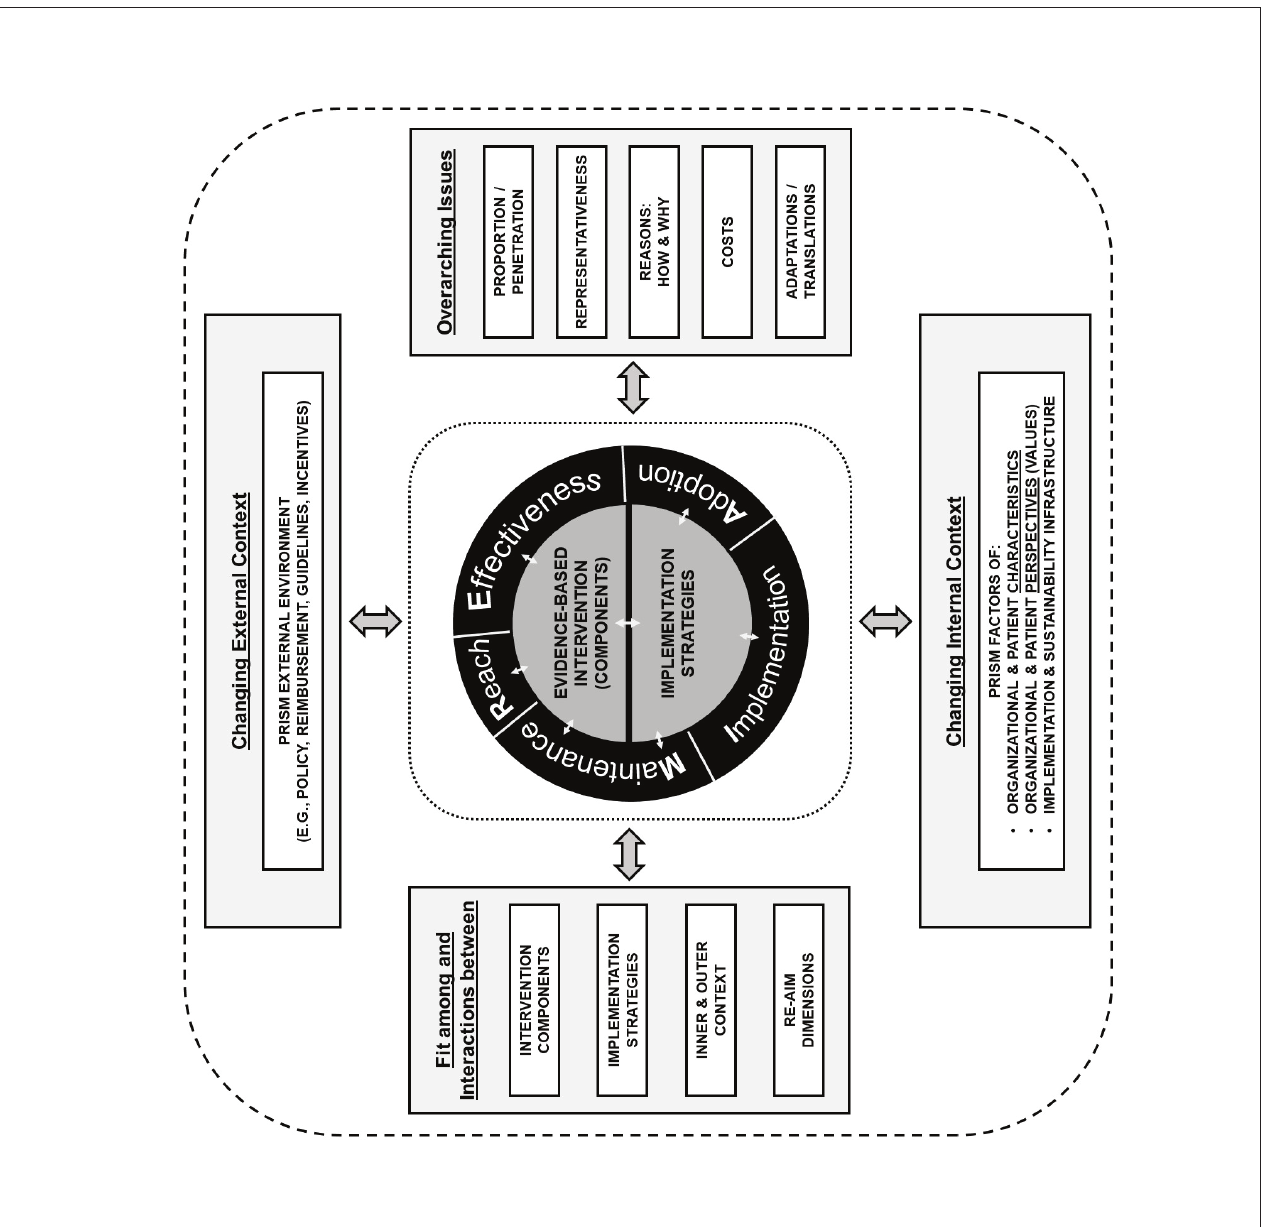
FIGURE 2 | PRISM. Reprinted from Glasgow RE, Harden SM, Gaglio B, Rabin B, Smith ML, Porter GC, Ory MG, Estabrooks PA. RE-AIM Planning and Evaluation Framework: Adapting to New Science and Practice With a 20-Year Review. Front Public Health. 2019 Mar 29;7:64. doi: 10.3389/fpubh.2019.00064, an